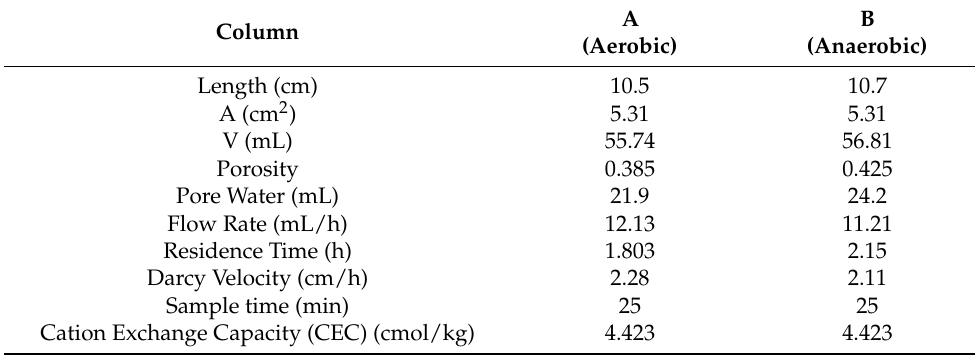
Table 2. Parameters used in the